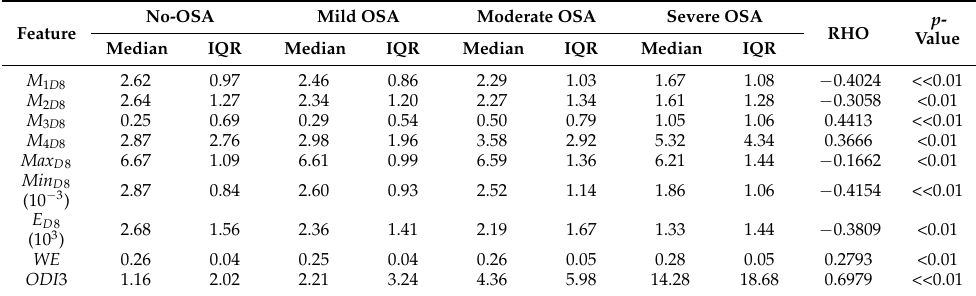
Table 2. Statistical analysis of the extracted features in the training group.